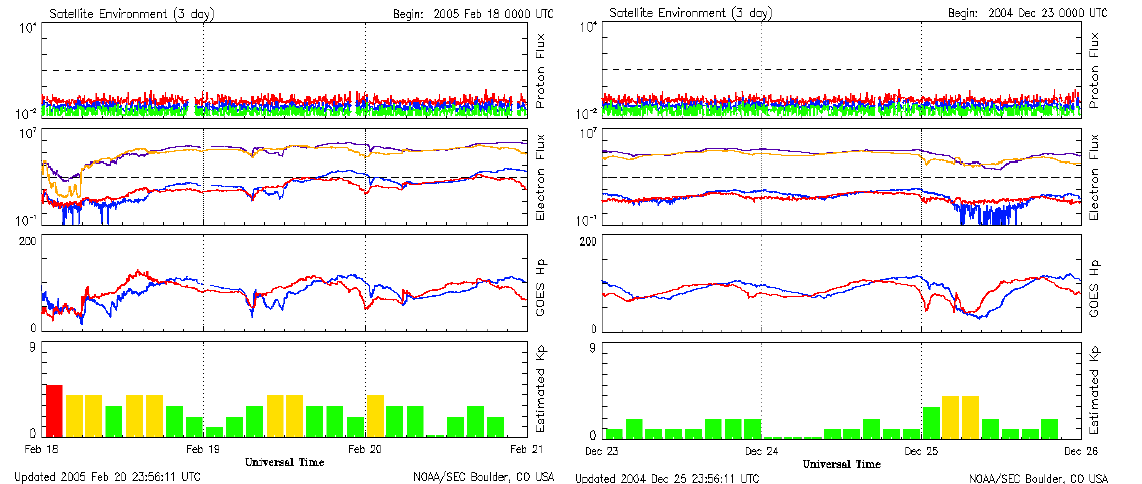
Figure 2. Influence of sunspots on Sun-Earth environment, showing low Kp and low E- flux before snowfall/rainfall, high Kp and high E-flux before an earthquake and very low Kp and low E-flux after an earthquake. Courtesy,